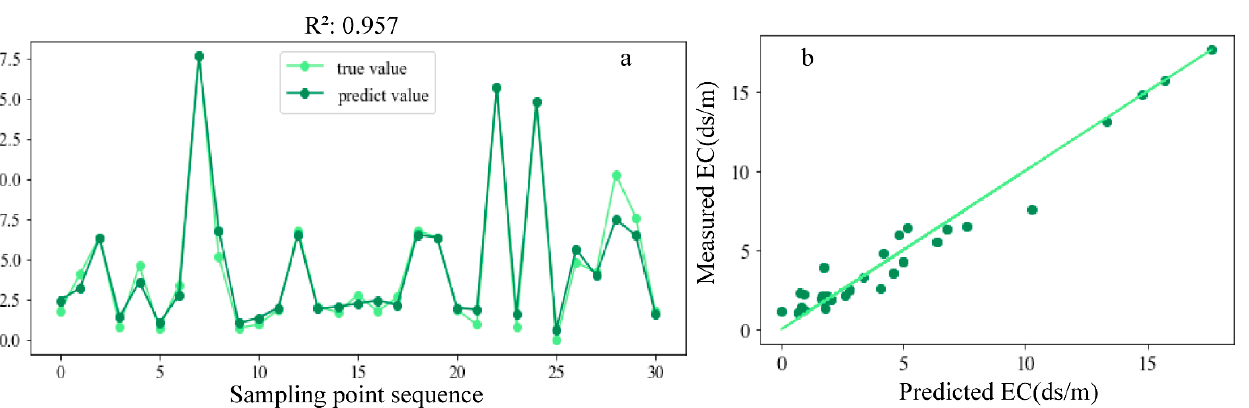
Figure 9. The normalized Taylor diagrams of the predicted and measured EC data ( a ) and the model accuracy comparison and mean squared error (MSE) of the six methods ( b ).